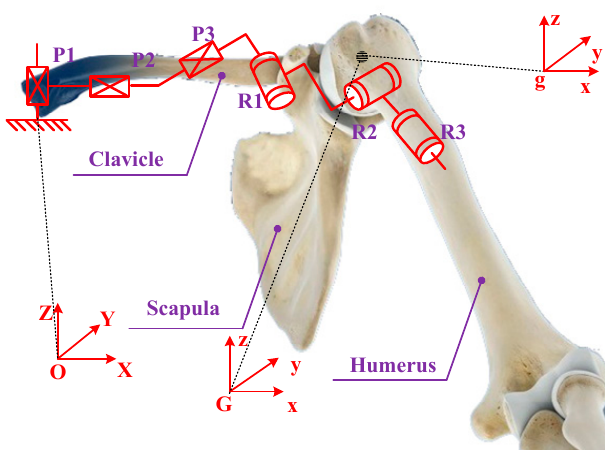
Figure 2. Mechanism model of the shoulder complex (P1, P2 and P3 denote three prismatic joints, while R1, R2 and R3 denote three revolute joints, respectively).